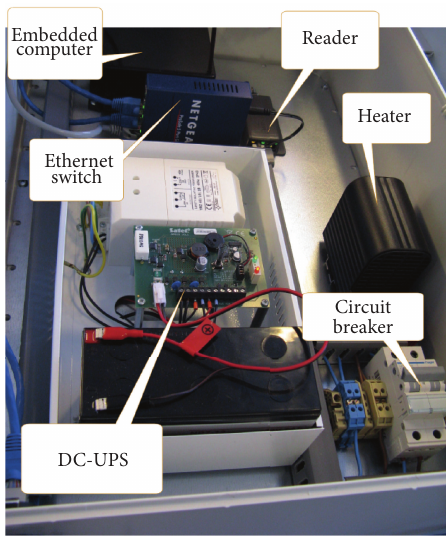
Figure 7: A LAN-reader with integrated computer.